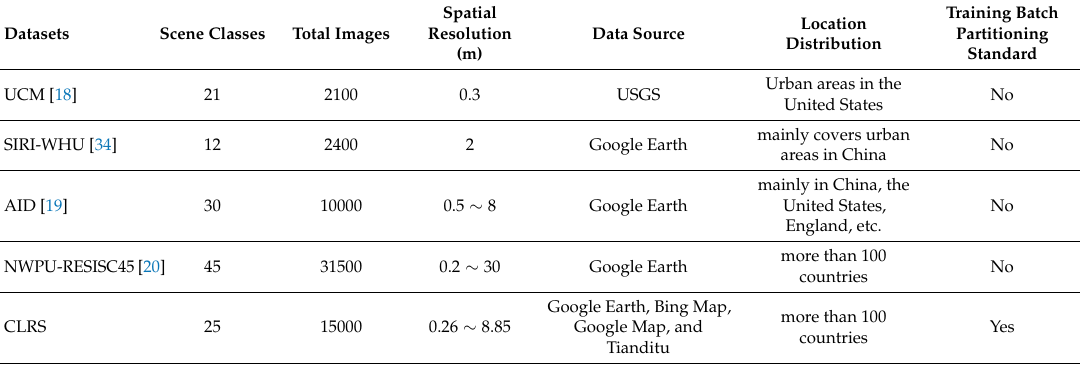
Table 3. Comparison between the CLRS and the existing remote sensing image scene classification